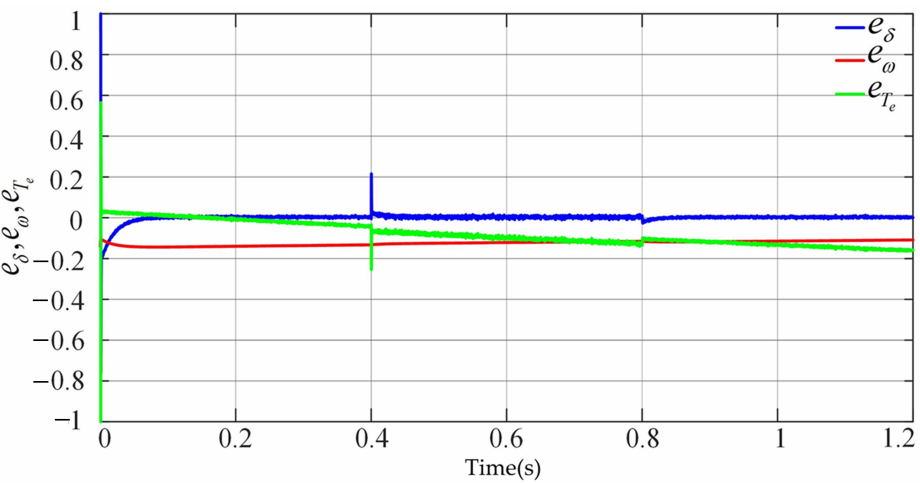
Figure 22. System tracking errors e δ , e ω , and e T